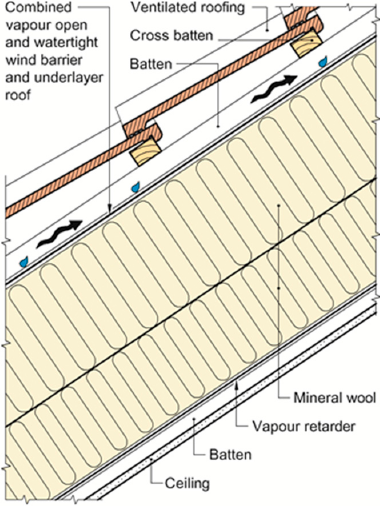
Figure 2. Roof Type B, which is an insulated pitched wooden roof with vapour open combined wind barrier and underlayer roof. All ventilation of the roof takes place in the air cavity below the roofing